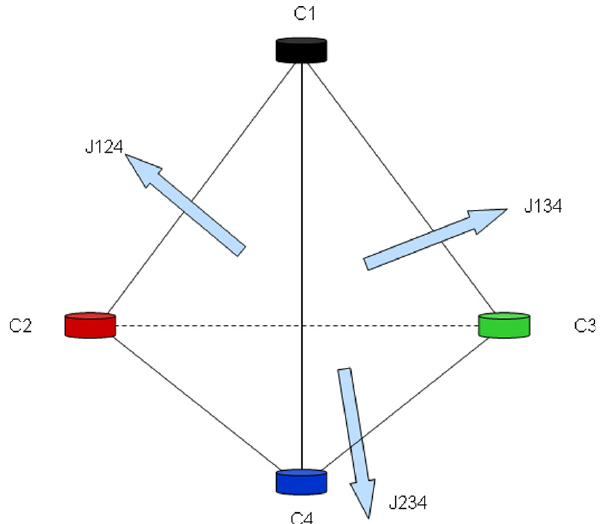
Fig. 1. Illustration of the average current density estimation using the curlometer (adapted from Dunlop et al.,